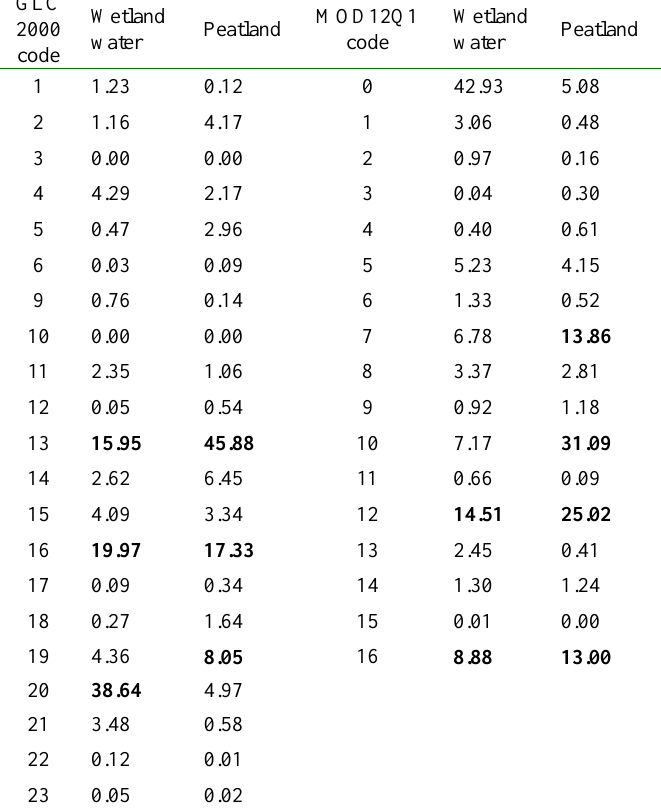
Table 5 the omission proportion (%) between the global land cover products and reference